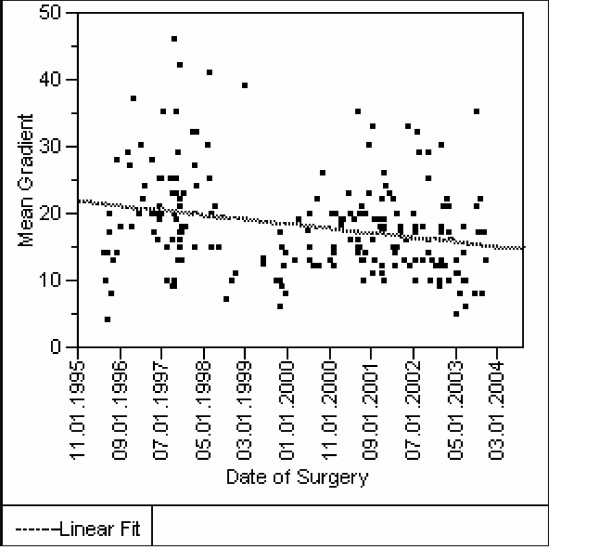
Learning curve of one surgeon concerning transprosthetic gradients after stentless valve implantation [p < 0.001]. The example of one surgeon shows that the mean gradients in subcoronary technique decrease during a time period of 8 years. Beside proper valve sizing and use of total root technique in difficult cases with small aortic roots, the phenomena can be best explained by the increasing ability of the surgeon to fit the valve smoothly into the aortic root and to handle the various aortic root geometries.